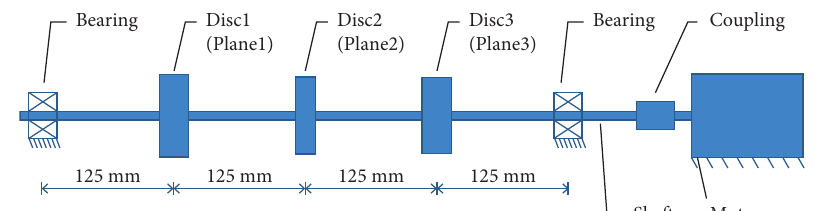
Figure 2: Schematic diagram of the rotor experimental system.